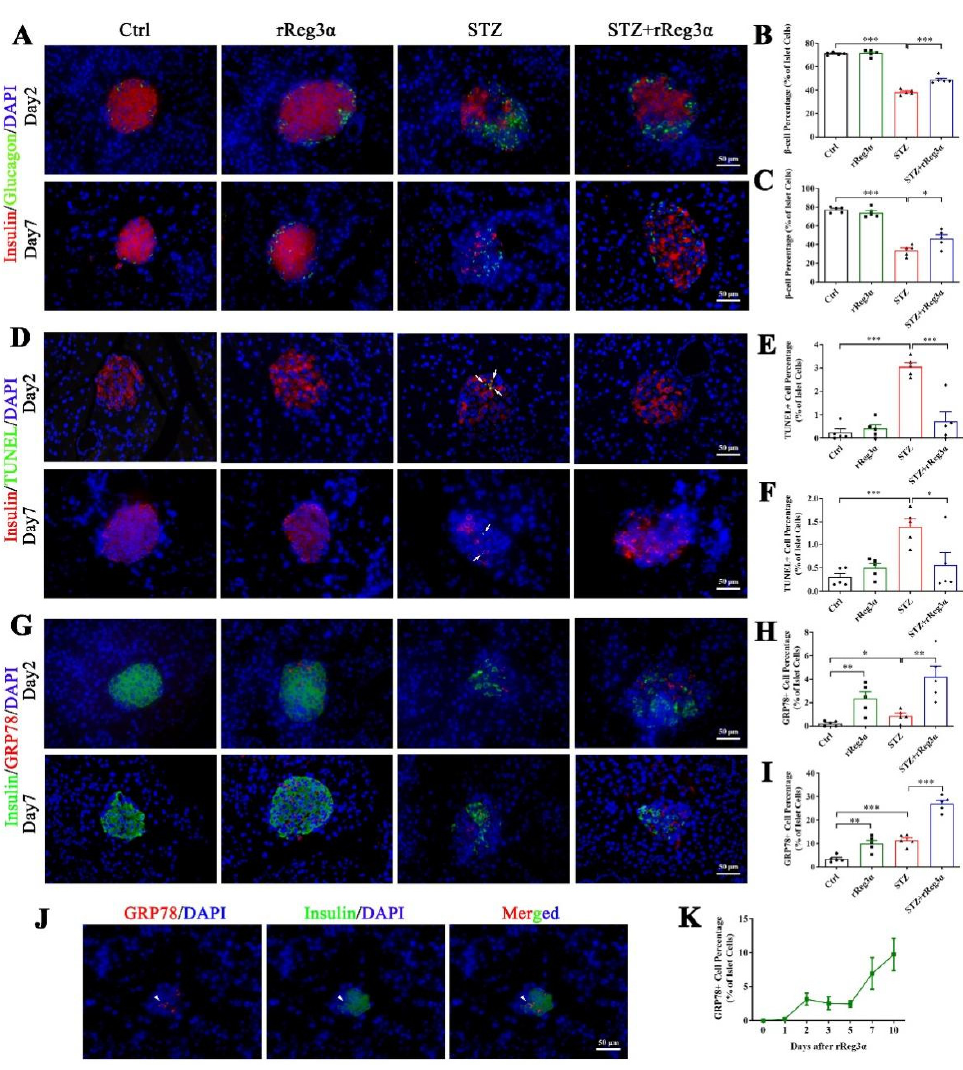
Figure 6. rReg3 α upregulates GRP78 expression and prevents β -cell apoptosis. ( A ) Immunofluores- cent staining to insulin and glucagon (400× magnification) at d 2 and 7 after STZ. Cell nuclei were labeled with DAPI. A representative image is illustrated from each group. ( B , C ) Statistical analysis of β -cell percentage in panel A. ( D ) Immunofluorescent staining to insulin and TUNEL (400× mag- nification) at d 2 and 7 after STZ. ( E , F ) Statistical analysis of TUNEL + cell percentage in the islets in panel D. ( G ) Immunofluorescent staining to insulin and GRP78 (400× magnification) at d 2 and 7 after STZ. ( H , I ) Statistical analysis of GRP78 high cell percentage in the islets in panel G. * p < 0.05, ** p < 0.01, and *** p < 0.001 using one-way ANOVA, N = 5. ( J ) Co-staining of insulin and GRP78 high in a minority of endocrine cells. A representative image is illustrated from all groups. ( K ) Detection of GRP78 high cells within 10 d after rReg3 α treatment without STZ, N = 3.